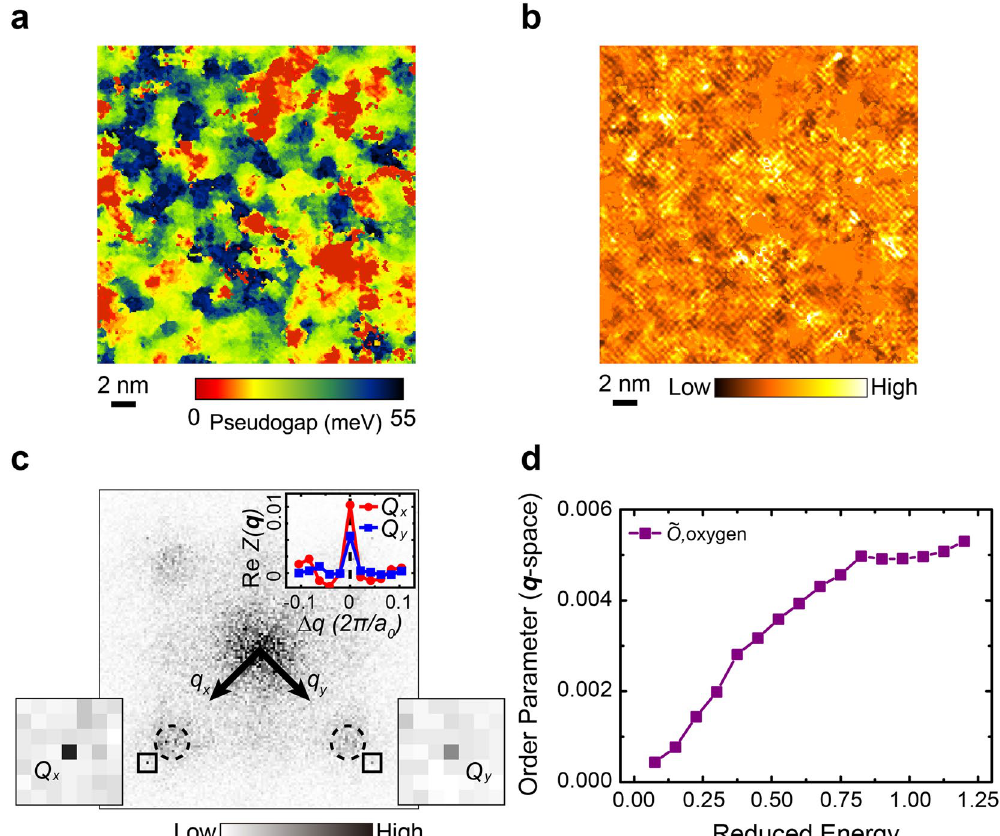
Figure 2. Ratio Z -map and collective nematic order ( q -space). ( a ) The PG map in the same FOV as in Fig. 1a. → ( b ) A typical ε Z r ( , ) map at the reduced energy of ε = 0.975, with the VHS regions filled with the spatial →∼ average value. ( c ) The Fourier transform ε Z q ( , ) map of panel b in the momentum space. For the four Bragg peaks, the positions at Q x and Q y are highlighted and enlarged, in which both Bragg peaks collapse into one pixel. In the inset, the real parts of the line cuts at Q x and Q y are shown in red and blue colors, respectively. The charge order is prominent at different wave vectors, as labeled by the dashed circles. ( d ) The collective order parameter as a function of ε in the momentum